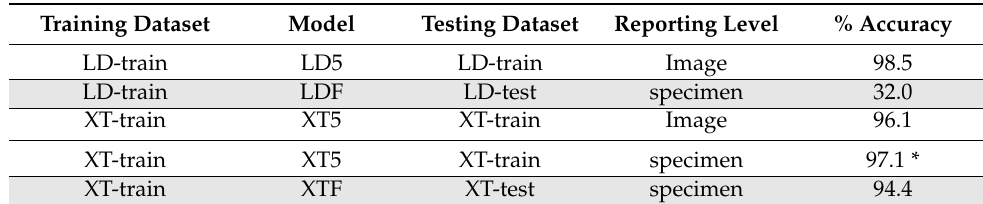
Table 3. Image and specimen level model prediction accuracies. The shaded rows report accuracies for proxy field testing and the unshaded rows report the cross-validation accuracies. The cross- validation accuracy reported in [37] was 92.6%. * The average accuracy (standard deviation: 0.5%) over 10 repeats of the process of selecting up to 5 images per specimen. Confusion matrices for each of the 10 repeats are presented in the